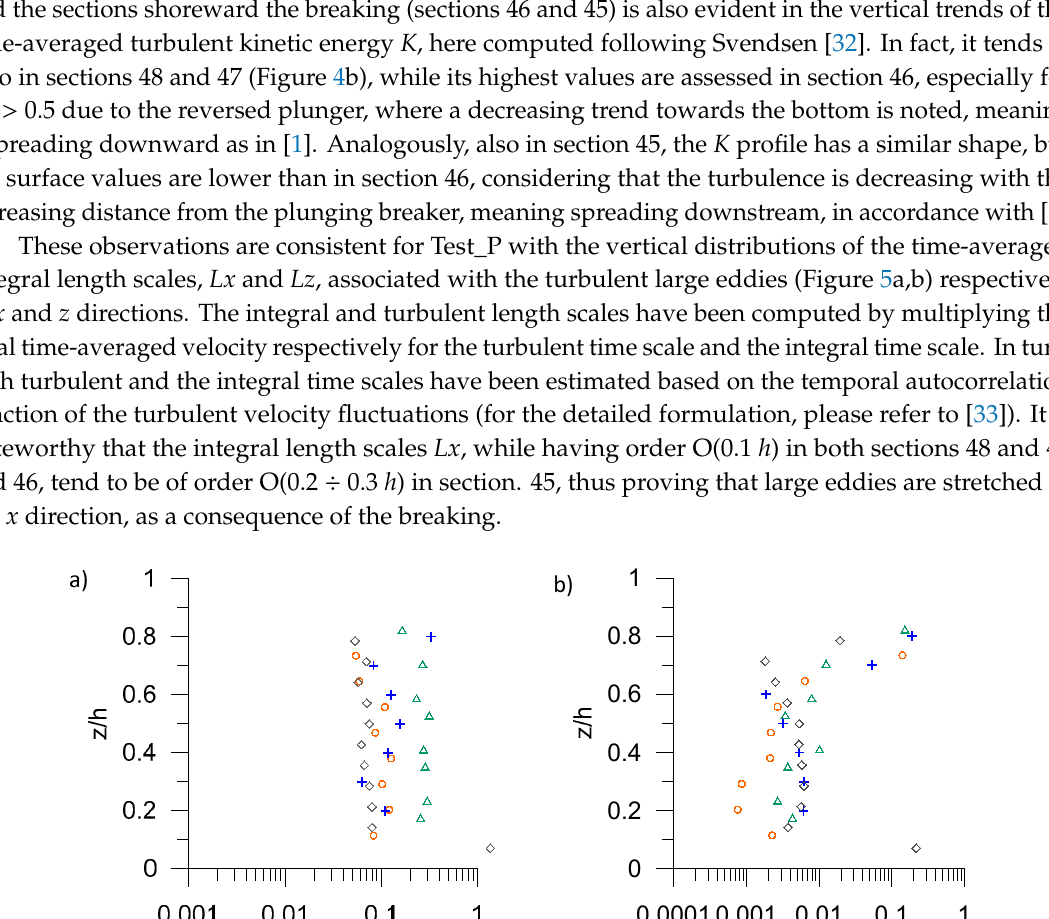
Figure 4. Test_P: vertical profiles of the time-averaged turbulent Reynolds stresses ( a ) and turbulent kinetic energy ( b ).